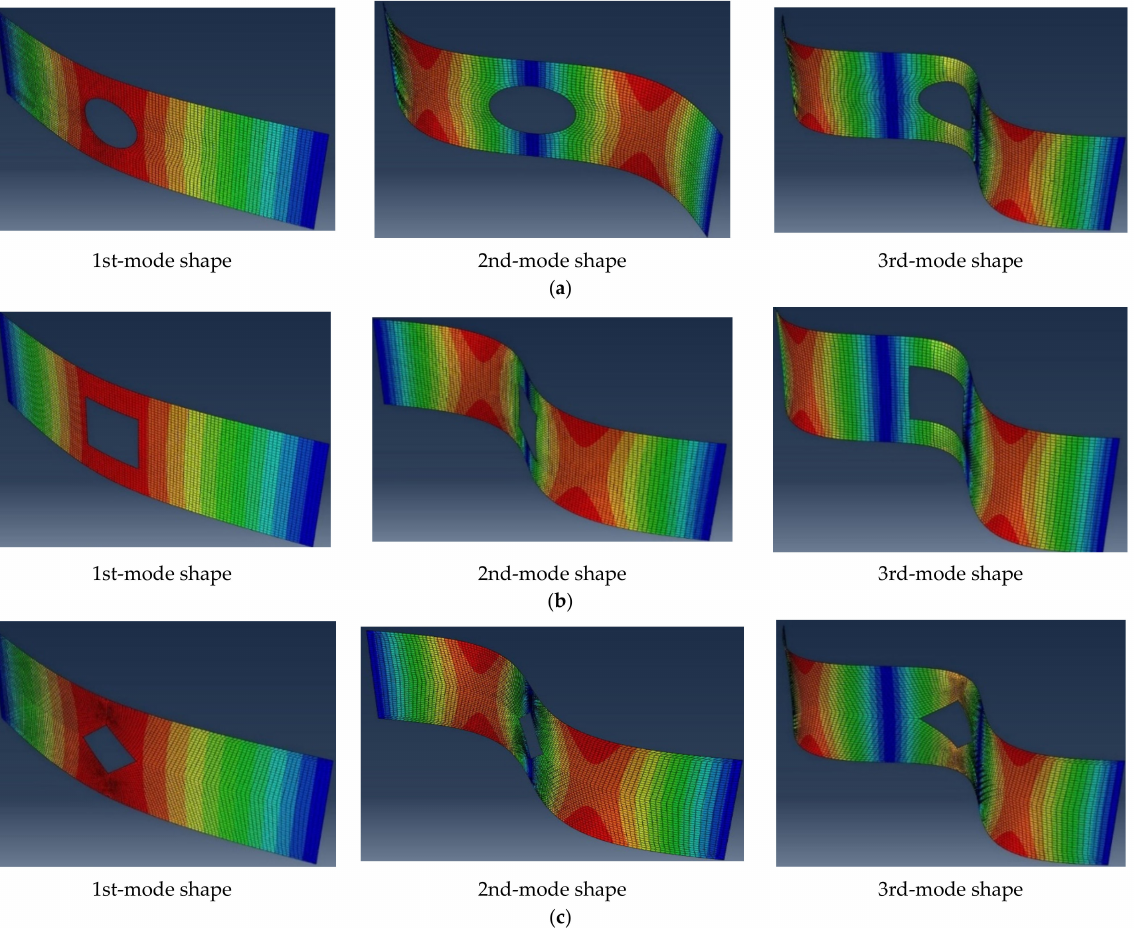
Figure 17. The first three buckling modes of the FGM plate for ( a ) circle, ( b ) square, and ( c ) dia- mond